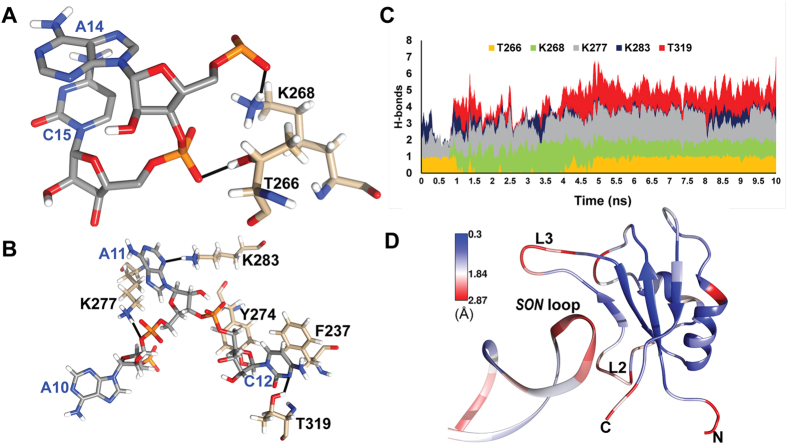
Interactions on RRM-RNA interface mainly mediated by hydrogen-bonding (shown as solid black lines) with the extended loop L2 (A), loop L3 and T319 on the carboxy terminus tail (B). Panel B also shows F237 and Y274 as the only two stacking amino acids. (C) Stacked bar graph showing hydrogen bonds between select interfacial amino acids and the SON loop through 10 ns of simulation time. (D) Ribbon representation of the complex colored by root mean squared fluctuation across the simulation, showing a high RMSF (Å) for A10-C15 on the SON loop and loops L2 and L3 on TAF15-RRM, despite a robust H-bonding network.